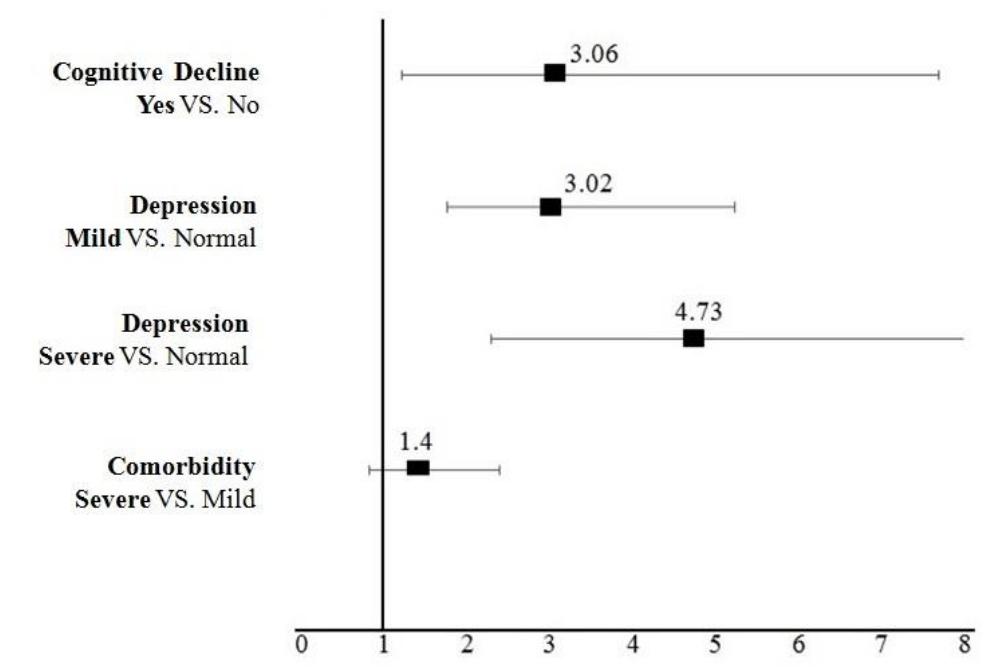
Figure 1. The impact of Geriatrics Syndromes on Frailty (univariate model analysis). Notes: An OR > 1 indicates a greater likelihood of elders having (Yes, Mild, Severe, VS., etc.) to be frail. Bars represent 95% Confidence Intervals (CI). Abbreviations: OR, odds ratio.